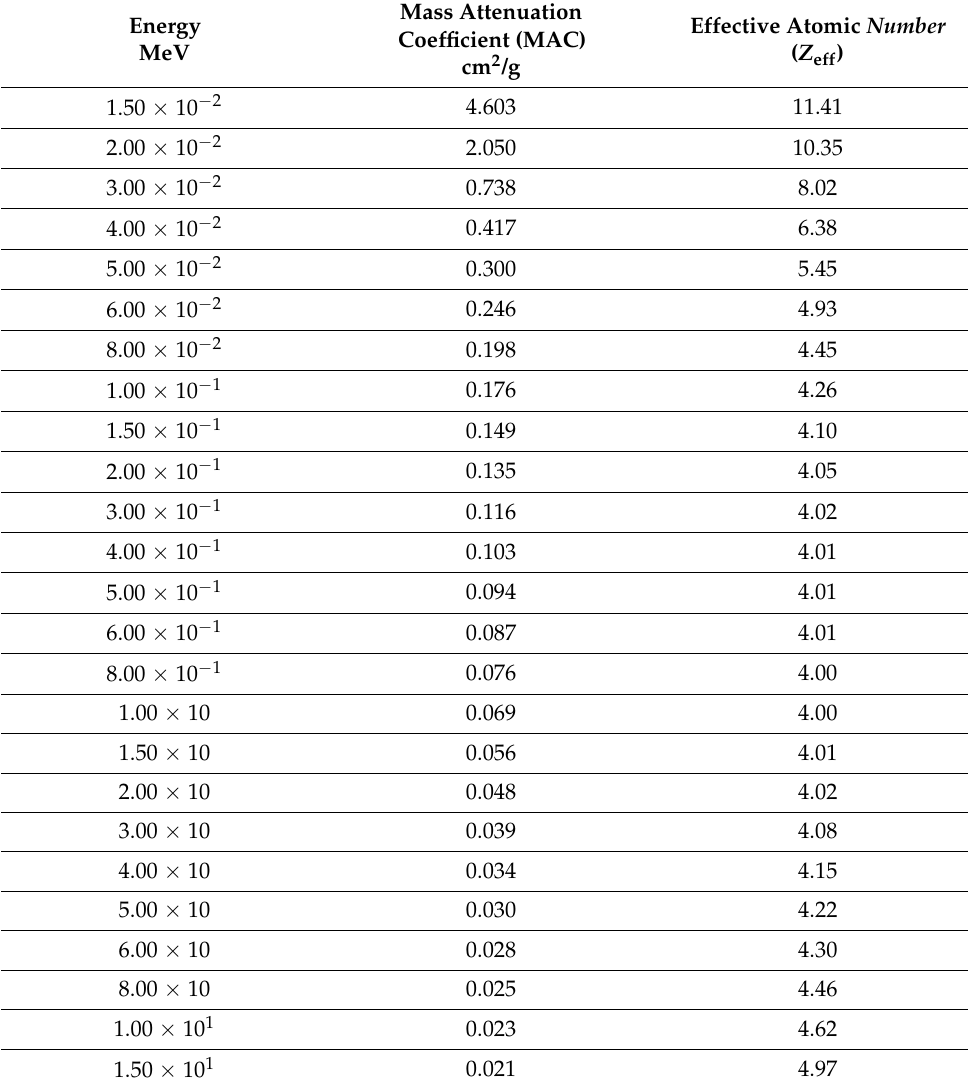
Table 2. Radiation attenuation properties of PDMS